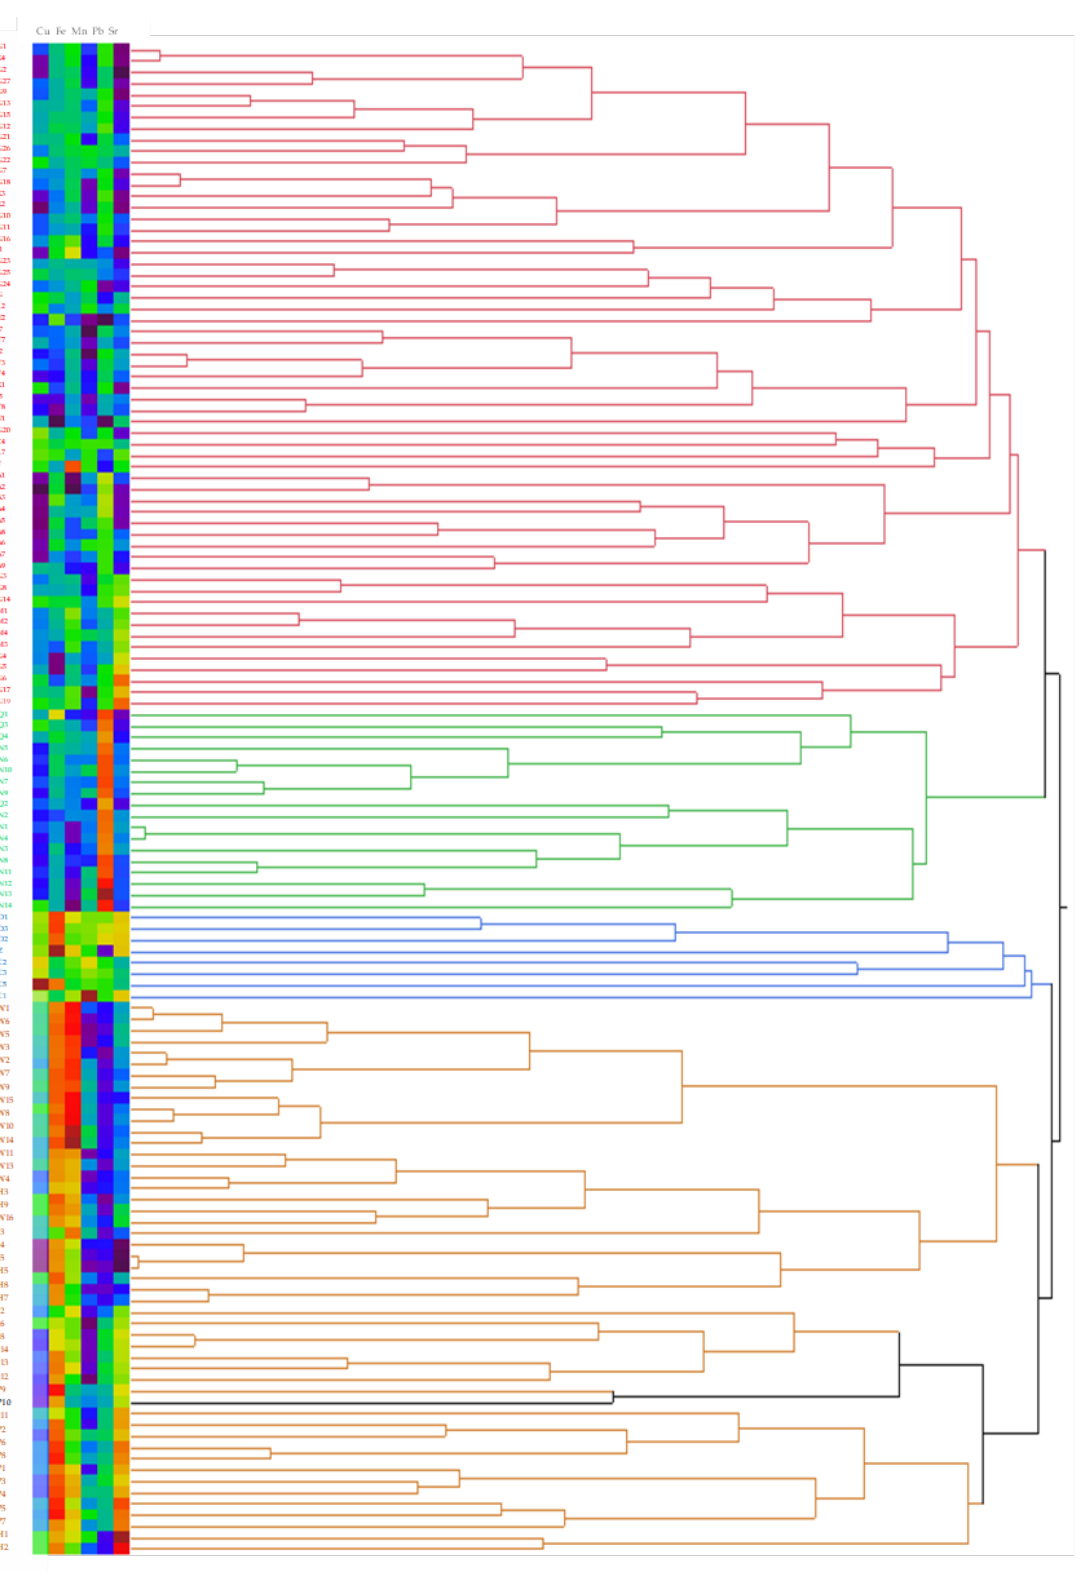
Figure 3. Cluster analysis including a dendrogram and a heat map. A — Armier Bay, C — Ballut Reserve Bay, G — Ghadira Bay, H — Gnejna Bay, I — Golden Bay, K — Little Armier Bay, L — Mistra Bay, M — Paradise Bay, N — Pretty Bay, O — Rinella Bay, P — Riviera Bay, Q —St. George’s Bay, S— Xemxija Bay, T — White Tower Bay, U — Hondoq Bay, W — Ramla Bay, Y — Xlendi Bay, Z — Marsalforn Bay.